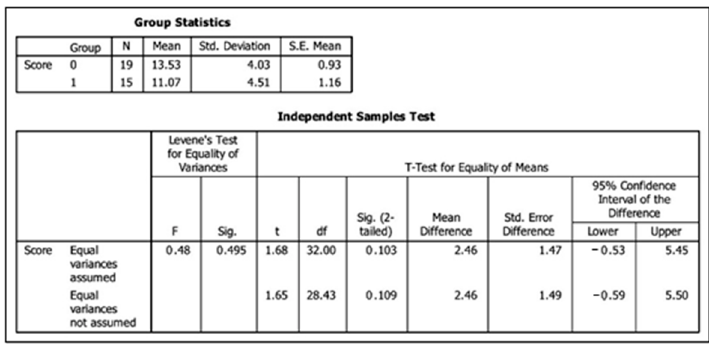
Figure 17. Independent t -test for the non-Computer Graphics group.